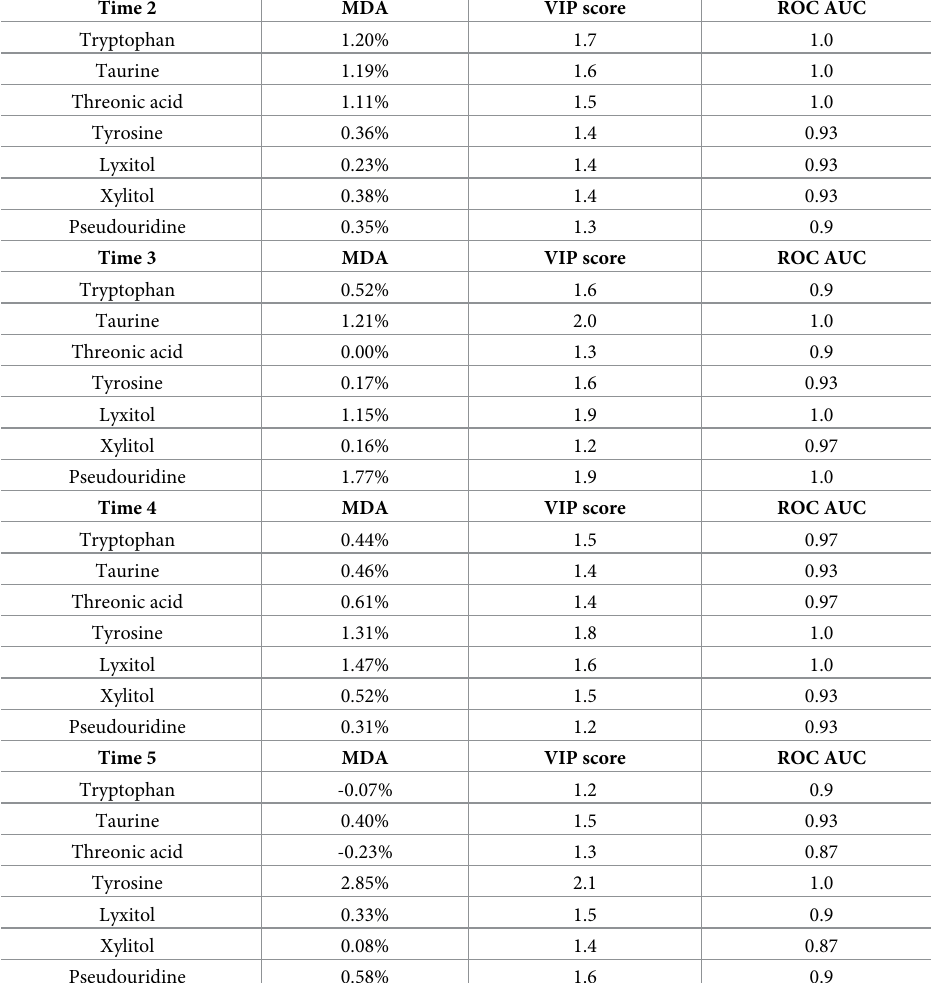
Table 2. List of putative urine biomarkers derived from the training data set. The selected seven urine metabolites were the only compounds in this study which met the following inclusion criteria: MDA � 0.004, VIP score > 1.0, ROC AUC > 0.85 and in at least one treatment